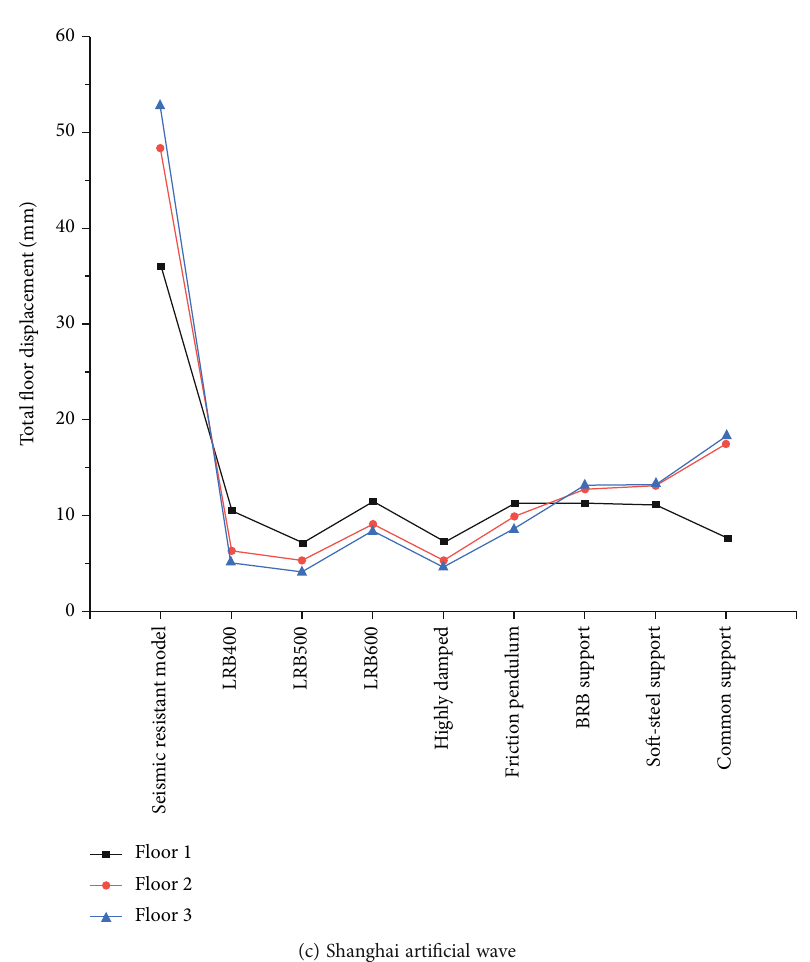
Figure 7: Comparison of total displacement of fl oors of various systems under di ff erent seismic